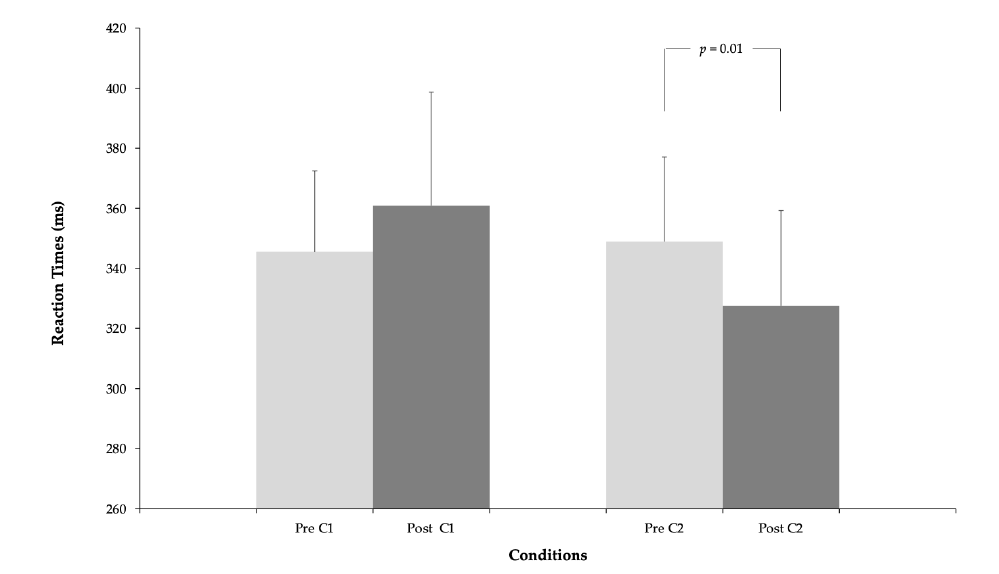
Figure 4. Mean RT ( ± STD) as a function of